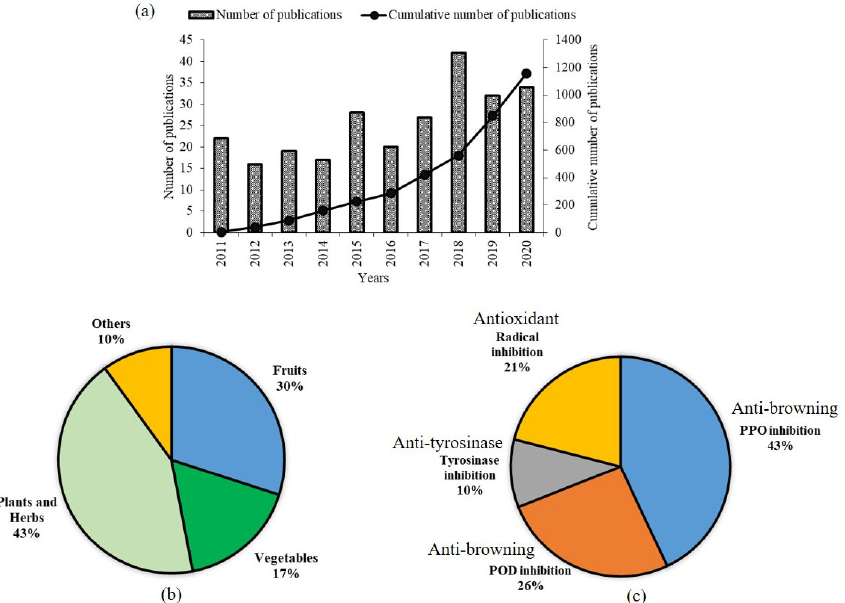
Figure 2. Annual and cumulative numbers of publications on the application of natural extracts in controlling enzymatic browning ( a ). Distribution of natural sources that possesses the ability to pre ‐ vent enzymatic browning ( b ). Distribution of natural ‐ based extracts with anti ‐ browning, antioxi ‐ dant and anti ‐ tyrosinase properties ( c ). The results are based on the recent studies that determined the enzyme (PPO, POD, and tyrosinase) and radical inhibition activities of extracts derived from selected fruits, vegetables, plants/herbs and others (animal by ‐ products), which were retrieved from WoS database.